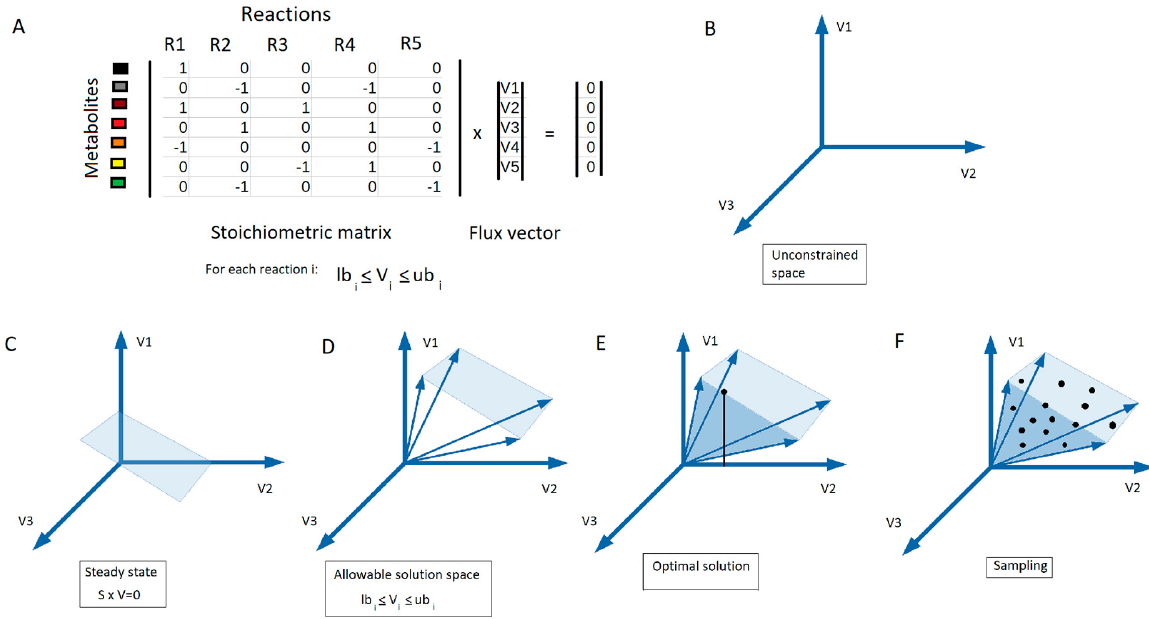
Figure 4. Genome-scale metabolic modeling. ( A ) FBA optimization maximizes a linear objective function, ψ ( v ), formed by the dot product of the flux vector containing each reaction flux, ( v i ) by a predetermined coefficient, c i , in the stoichiometric matrix ( S ) subject to a steady-state assumption, Sv = 0, as well as lower and upper bounds on each reaction flux ( lb i and ub i ). From the unconstrained space ( B ), the allowable solution space is defined by specifying the steady-state assumption ( C ), as well as lower and upper bounds on each reaction flux ( D ). Various methods can then be used to interrogate the solution space, such as ( E ) optimization for a biologically motivated objective function to identify a single optimal solution (e.g., flux vector in case FBA optimization method is used) or ( F ) sampling to provide an unbiased characterization via flux vectors uniformly distributed in the solution